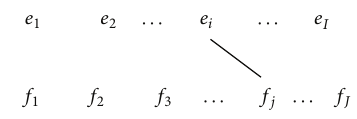
Figure 5: Sentences with single alignment link.